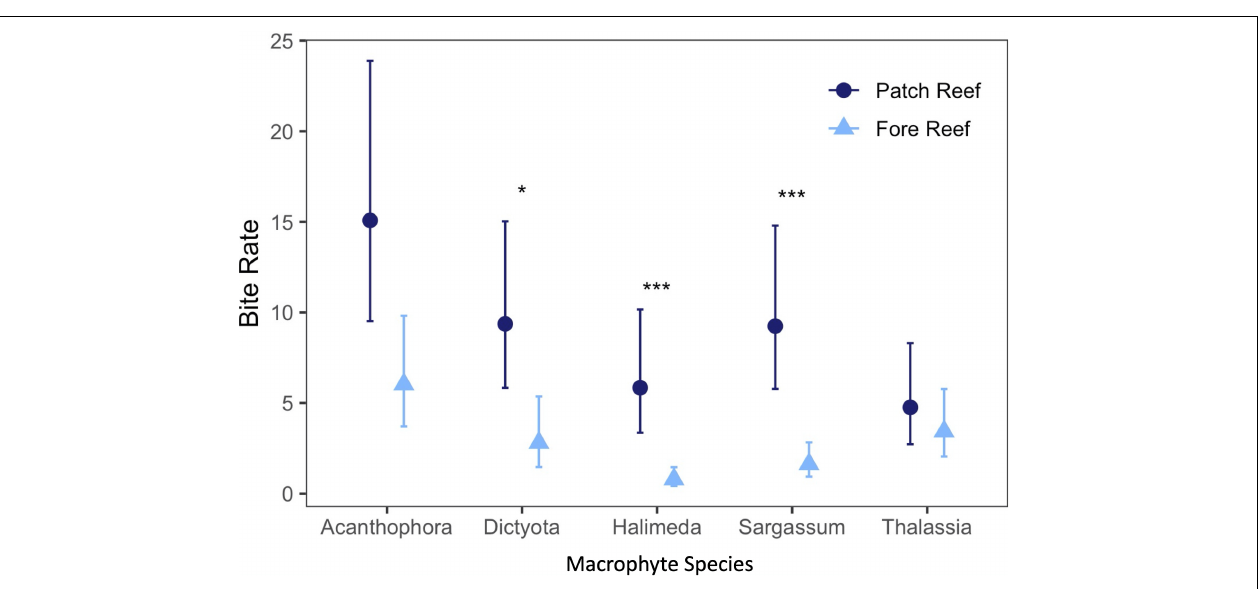
One explanation for the observed variation in